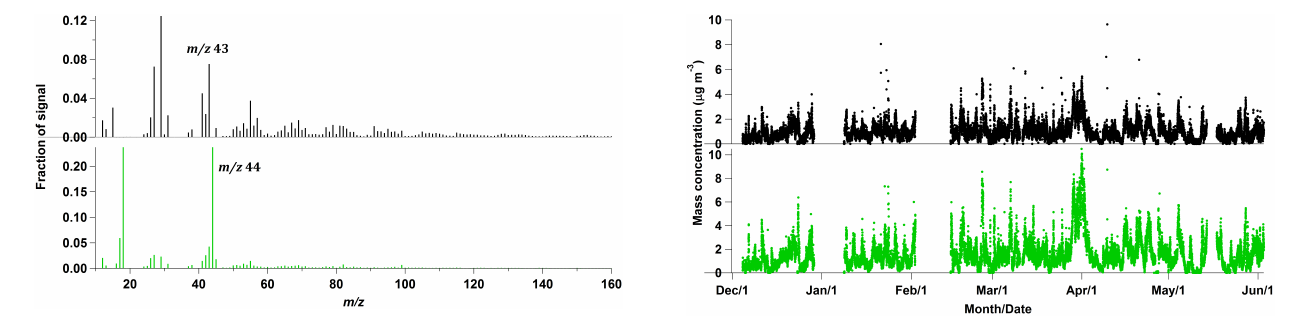
Figure 3. Temporal variation of mass concentration of HOA (or- ange) and LV-OOA (green) obtained by PMF analysis.